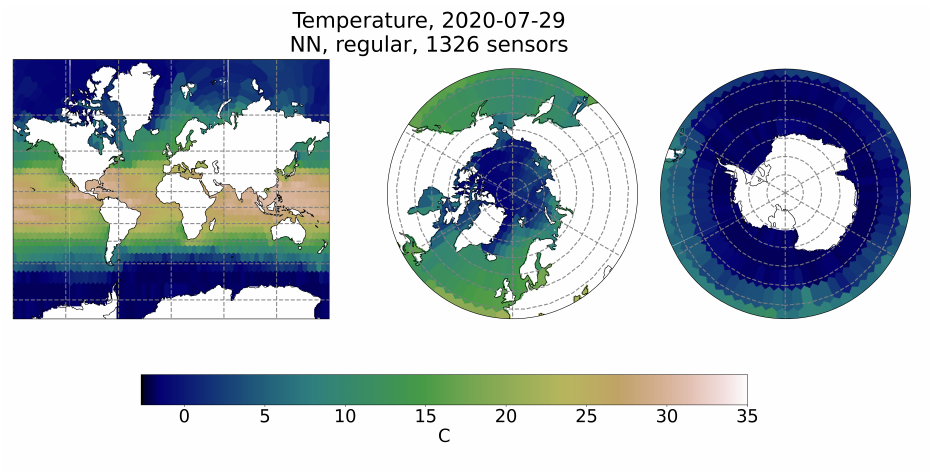
Figure 10. Reconstructed field using the Nearest Neighbor (NN) method from 1326 measurements with regular placement.